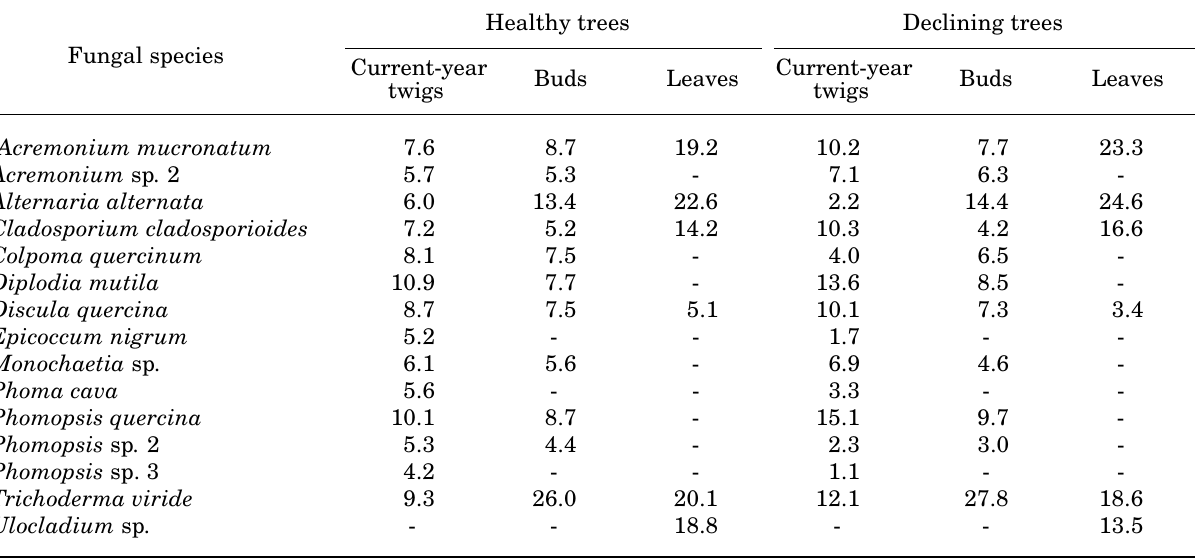
Table 1. Isolation frequency of fungal species from healthy and declining Quercus cerris trees in 1999 and 2000. Data are percentages of each fungus over total fungi isolated from that organ summing data of all samplings